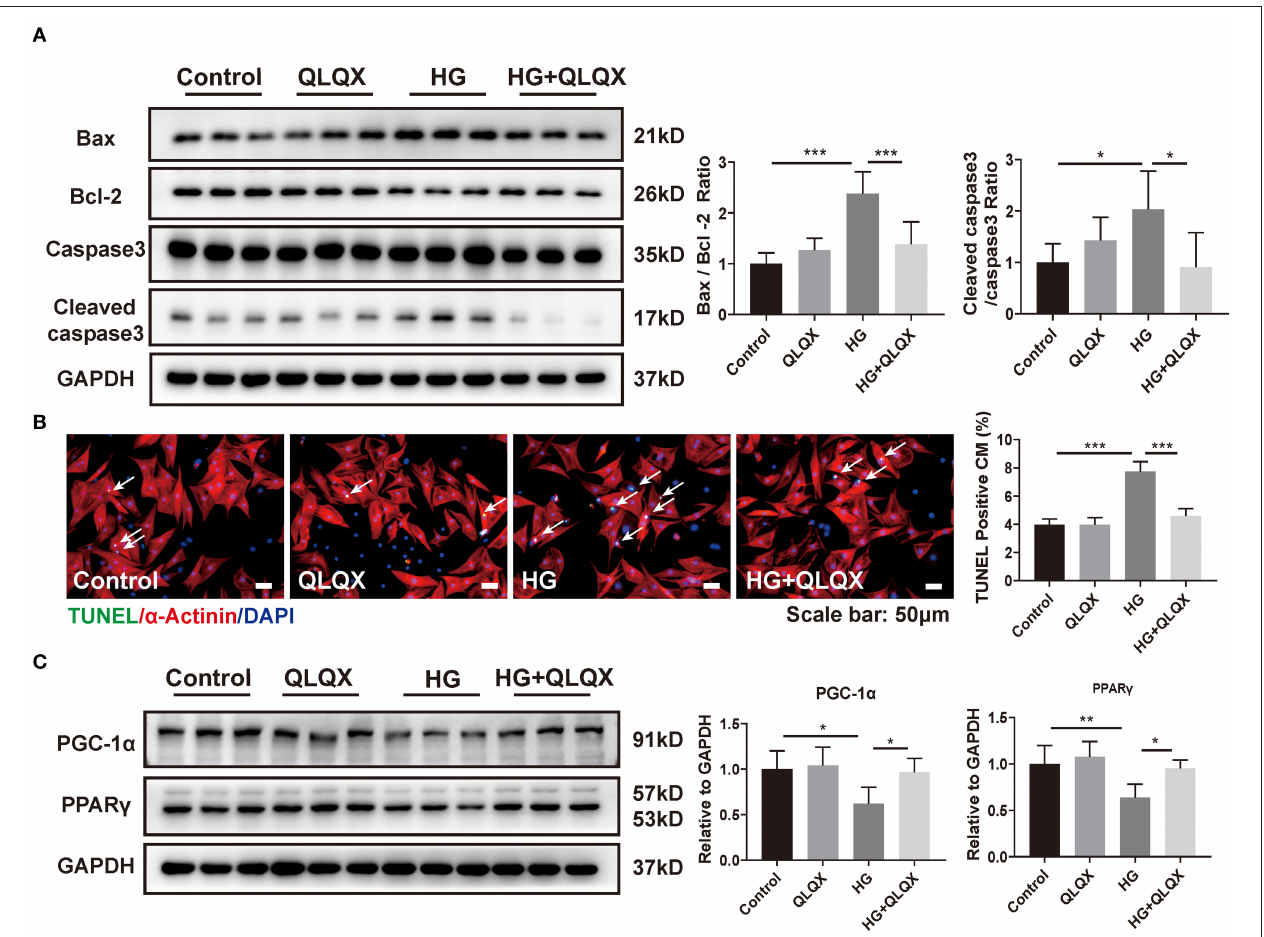
FIGURE 2 | QLQX attenuates HG-induced NRCM apoptosis and activates PPAR γ /PGC-1 α . (A,B) Western blot analysis and TUNEL assay indicated that QLQX attenuated cardiomyocyte apoptosis resulting from HG stimulation. Scale bar: 50 µ m ( n = 6). (C) QLQX blocked the reduction effects of HG on expressions of PPAR γ and its co-activator PGC-1 α ( n = 6). * p < 0.05; ** p < 0.01; *** p < 0.001; vs. respective